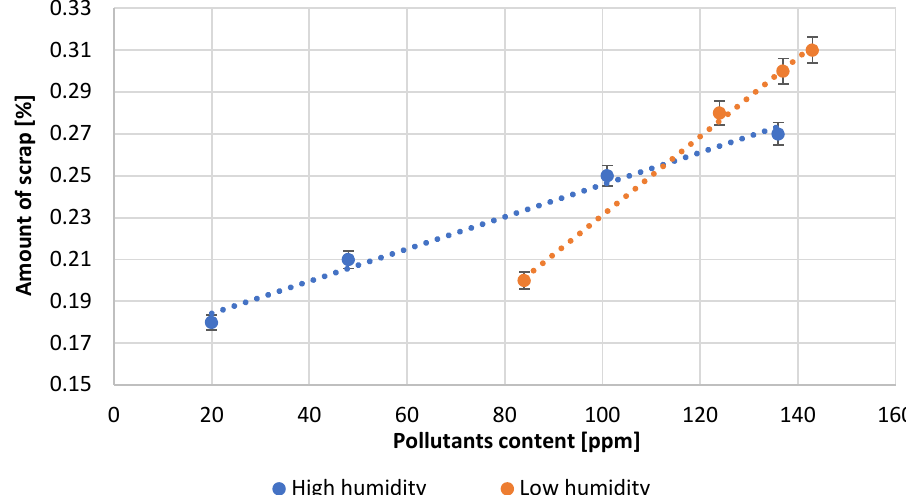
Figure 8. Dependence of scale formation on pollutants content.